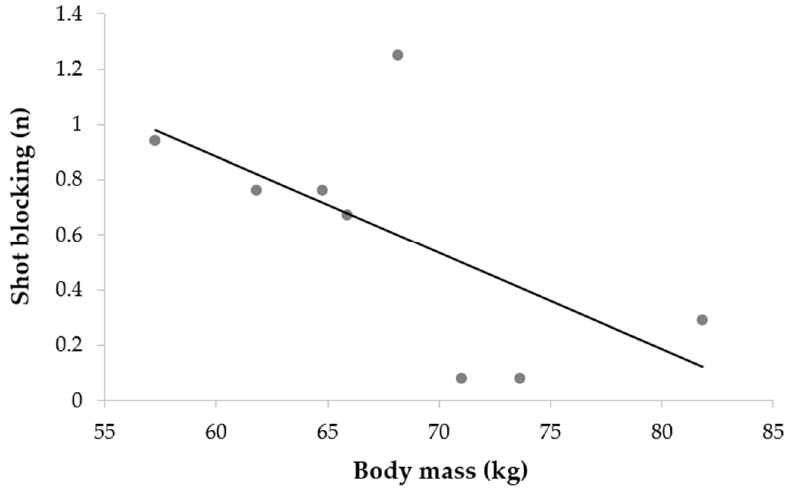
Figure 4. Association between body mass and shot blocking (game blocked shots).